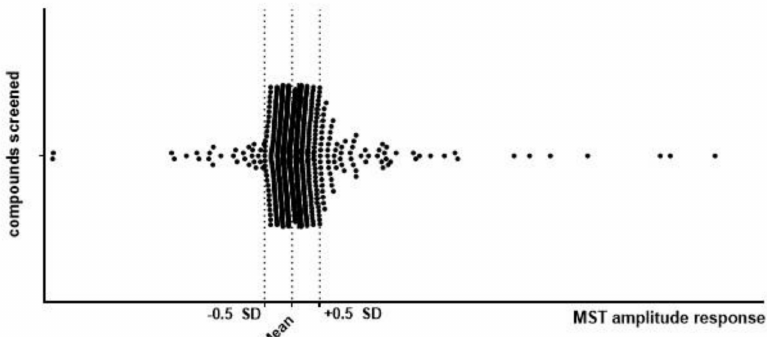
Figure 1. Results of primary screening using the MST technique. Screening of 987 compounds was performed by examination of signal amplitude between the unbound and bound state of the molecule and the exTrkB receptor. Compounds were screened in single-point MST at concentrations of 0.5 mM for small molecular compounds and 20 nM exTrkB. Compounds with amplitudes greater than 0.5 SD were selected for further analysis.